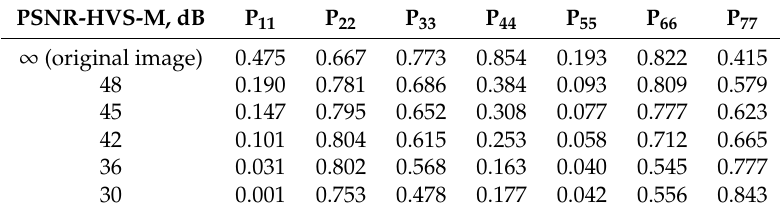
Table 2. Probabilities of correct classifications for particular classes depending on image quality.